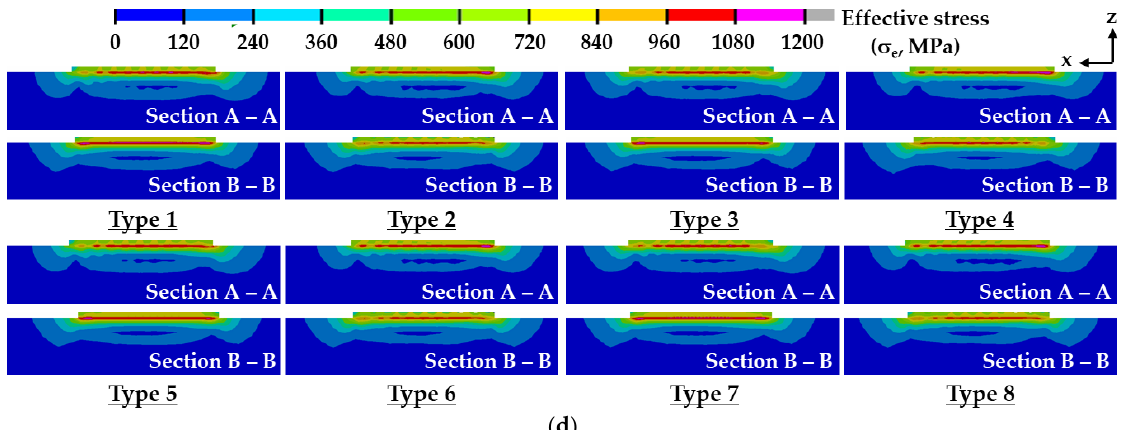
Figure 9. Effects of deposition strategies on effective stress distributions after the completion of cooling for a small volume deposition: ( a ) Three-dimensional distributions for type 5 path of ADDSs and cross-sections for residual stress distributions in the TD; ( b ) regions to estimate cross-sectional distributions of effective stress; ( c ) effective stress distributions in the TD (ADDS); ( d ) effective stress distributions in the TD (UDDS).